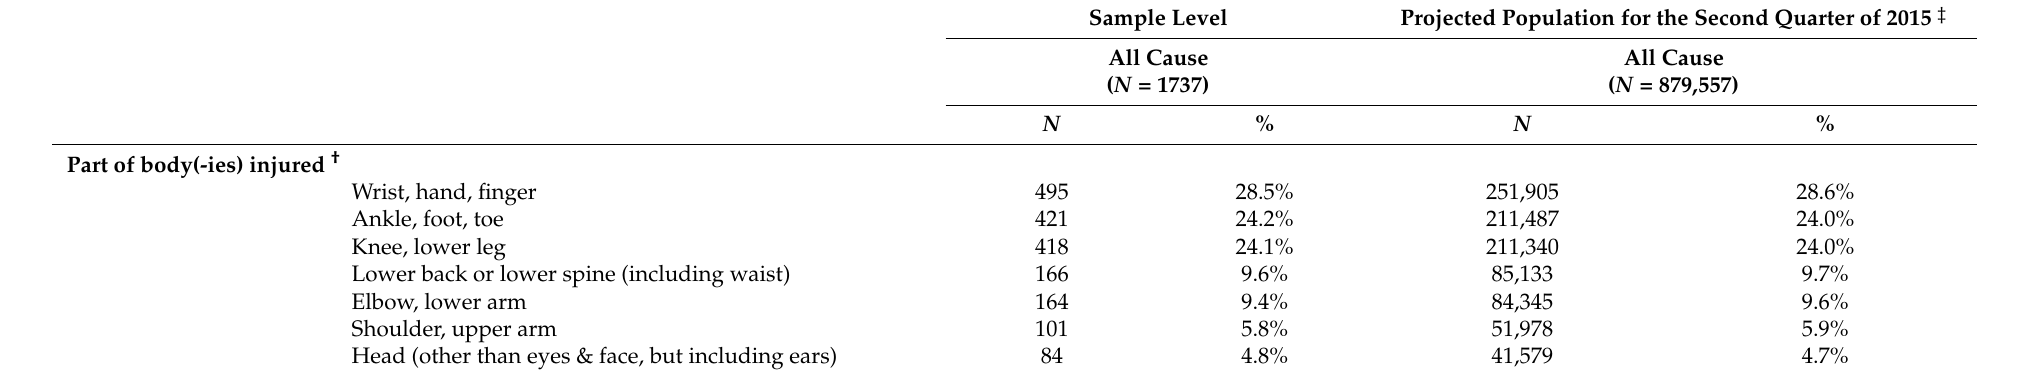
Table 3. Part of body injured, location of injury, and whether injury was work-related among the most severe injury